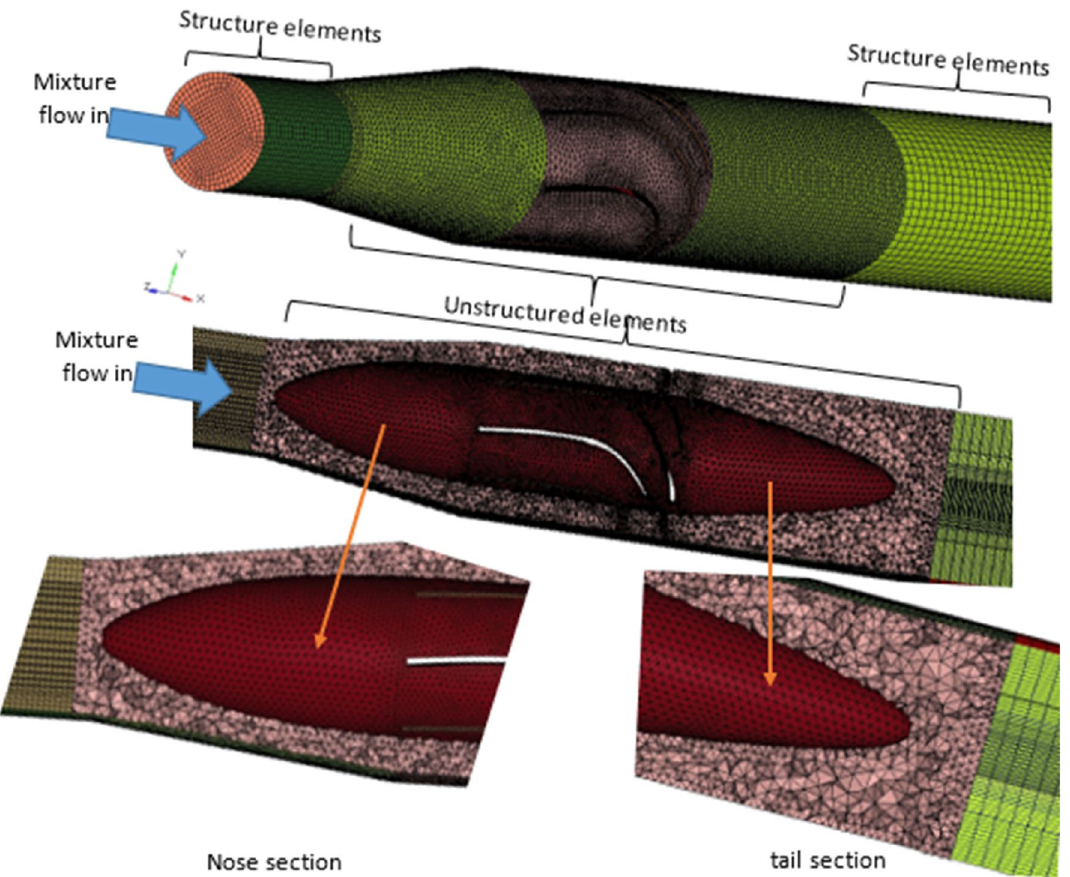
Fig. 4 View of the meshed elements with 980 × 10 3 cells. a The top part is hybrid meshing including the swirler, upstream and downstream of the swirler, b the bottom is enlarged view of the hexahedral unstructured elements in the swirler